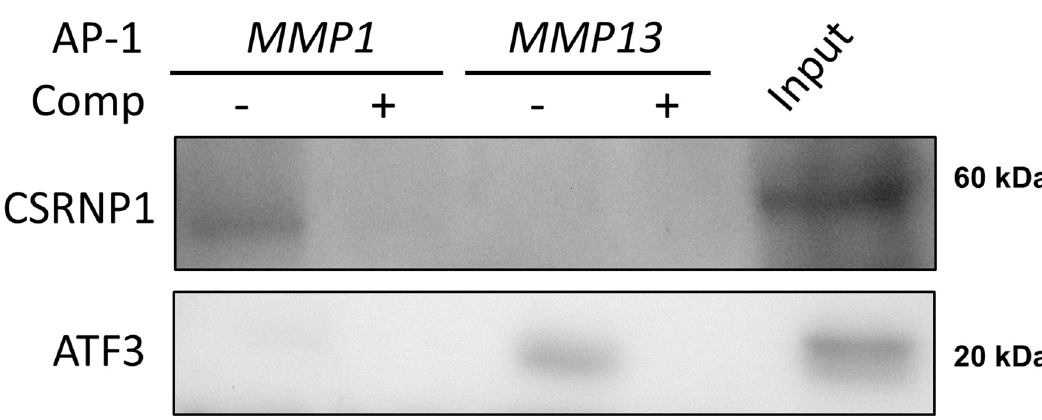
Fig 7. CSRNP1 selectively binds the proximal MMP1 AP-1 motif at a transcriptionally active time-point in IL-1+OSM- stimulated chondrocytes. Human chondrocytes were treated with IL-1 (0.2 ng/mL) in combination with OSM (10 ng/mL) for 3 h. Nuclear lysates were prepared and subjected to either Western blotting alone (input) or DAPA with CSRNP1 or ATF3 antibodies, as described in the Materials and Methods. Non-biotinylated AP-1 oligonucleotides (50x excess; Comp) were used to confirm specificity of binding in the DAPAs. The data are representative of 3–5 separate experiments each using chondrocyte cultures from different